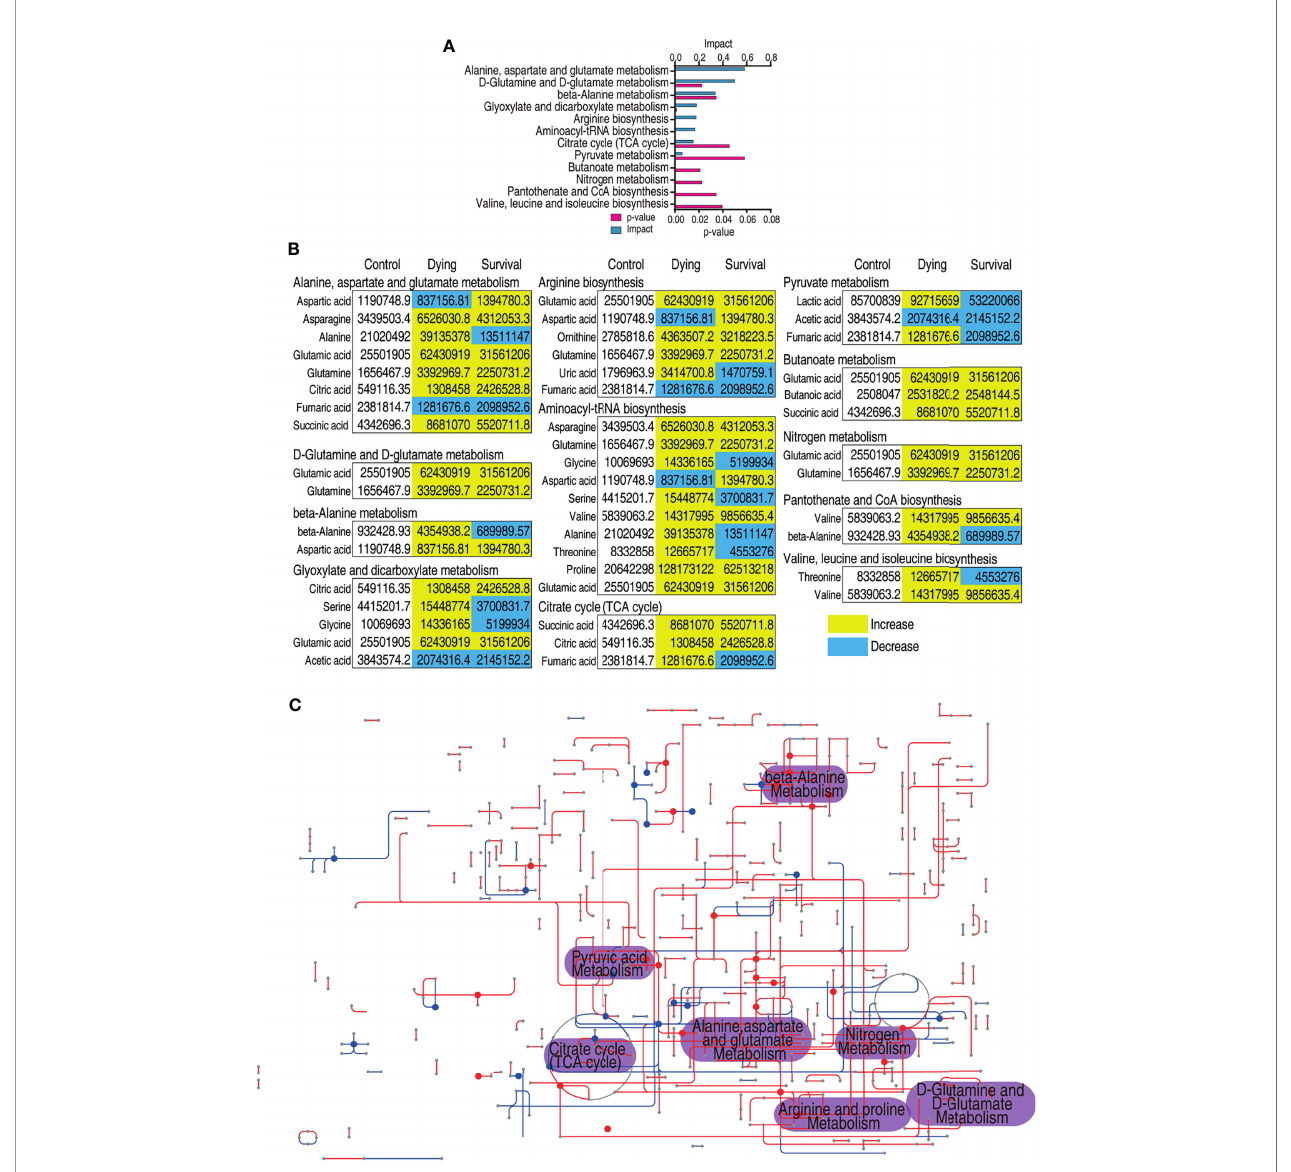
FIGURE 2 | Pathway enrichment analysis of differential metabolites. (A) Pathway enrichment analysis of differential metabolites. Signi fi cantly enriched pathways were selected to plot (p value <0.05), and their impact score was indicated. (B) The relative abundance of metabolites of each pathway listed in (A) . Metabolites highlighted with yellow and blue indicate the increased and decreased abundance, respectively. (C) Integrated metabolic network of differential metabolites of dying group against survival group by iPath3.0. The red and blue lines represent the increased and decreased metabolites,